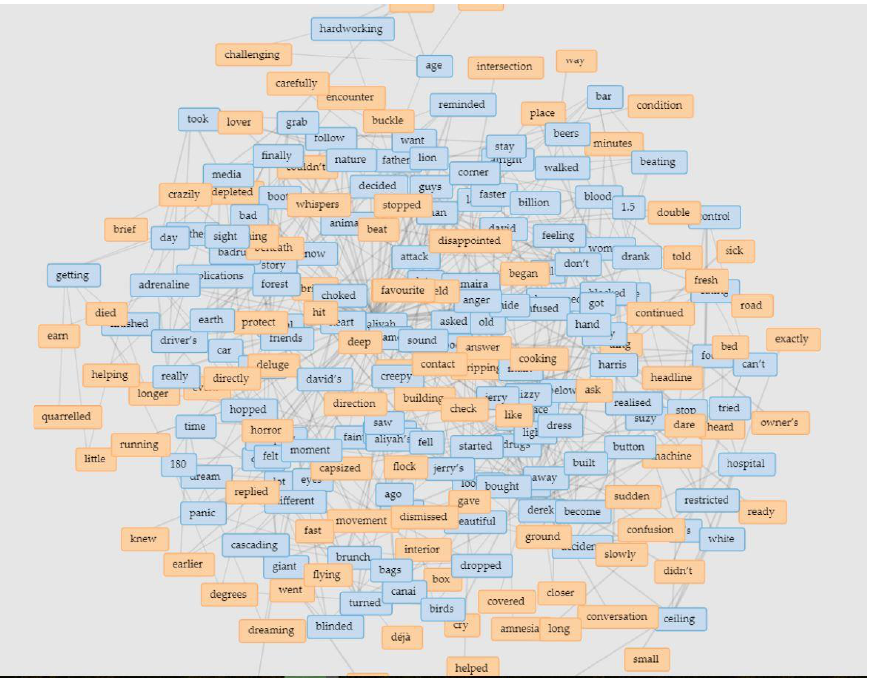
Figure 3. High Frequency Words in Storyboarding (Source: Voyant Tools).